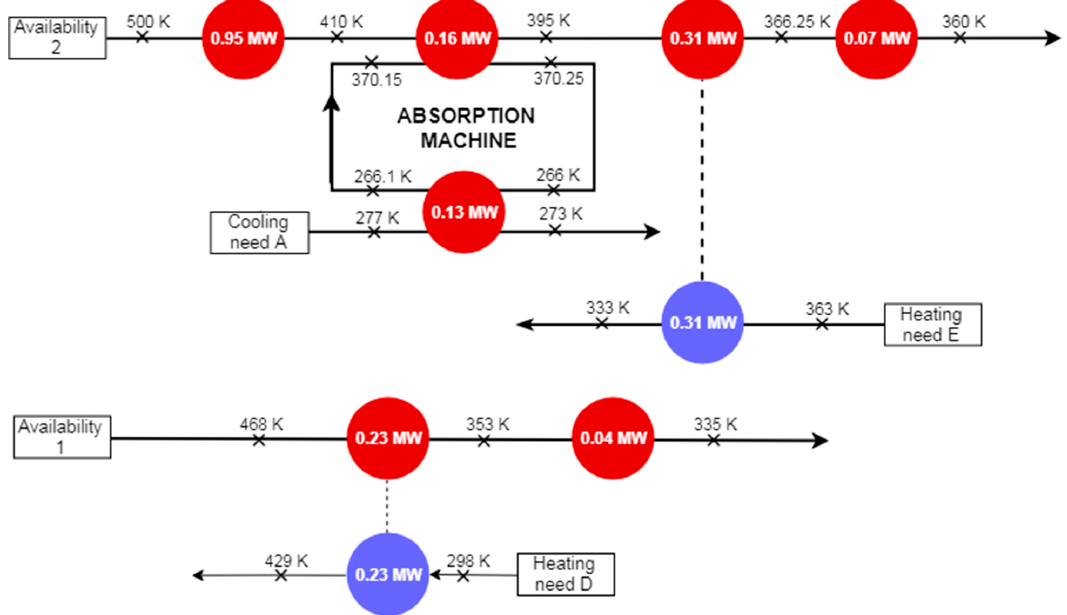
Figure 21. Scenario (1 + 2 + 3) design.